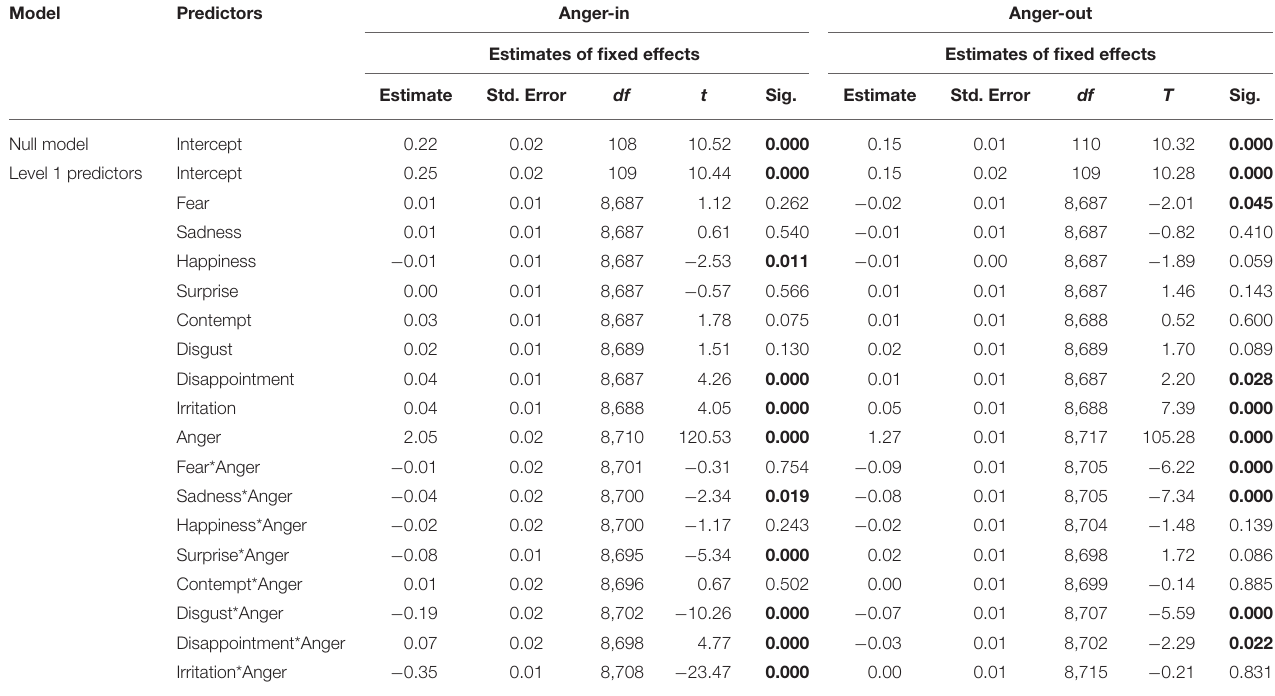
TABLE 1 | The null model and Level 1 fixed effects model of anger-in and anger-out behaviors. Model Predictors